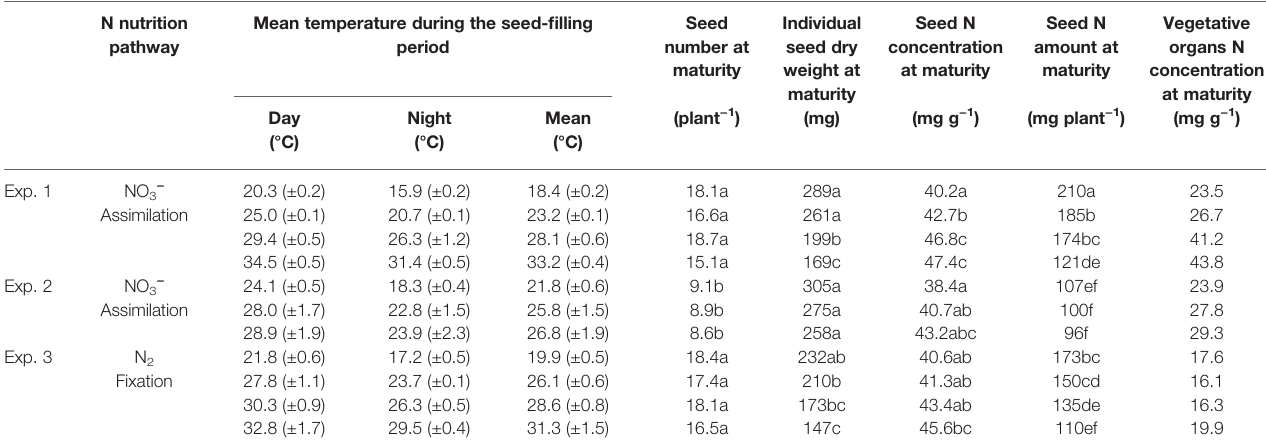
TABLE1 | Glasshouse experiments characteristics and seed number, individual seed dry weight, seed N concentration and amount, and vegetative organs N concentration at maturity. N nutrition